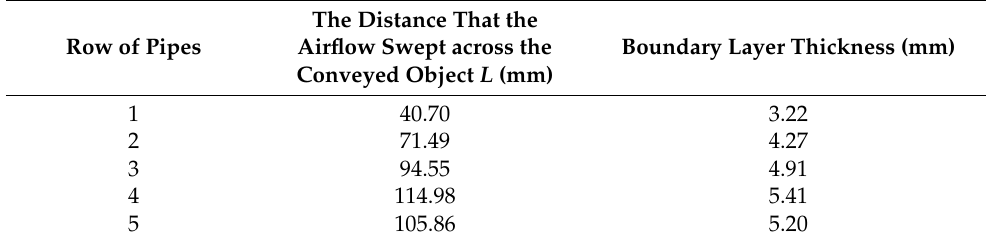
Table 3. Boundary layer thickness of each row of pipes.